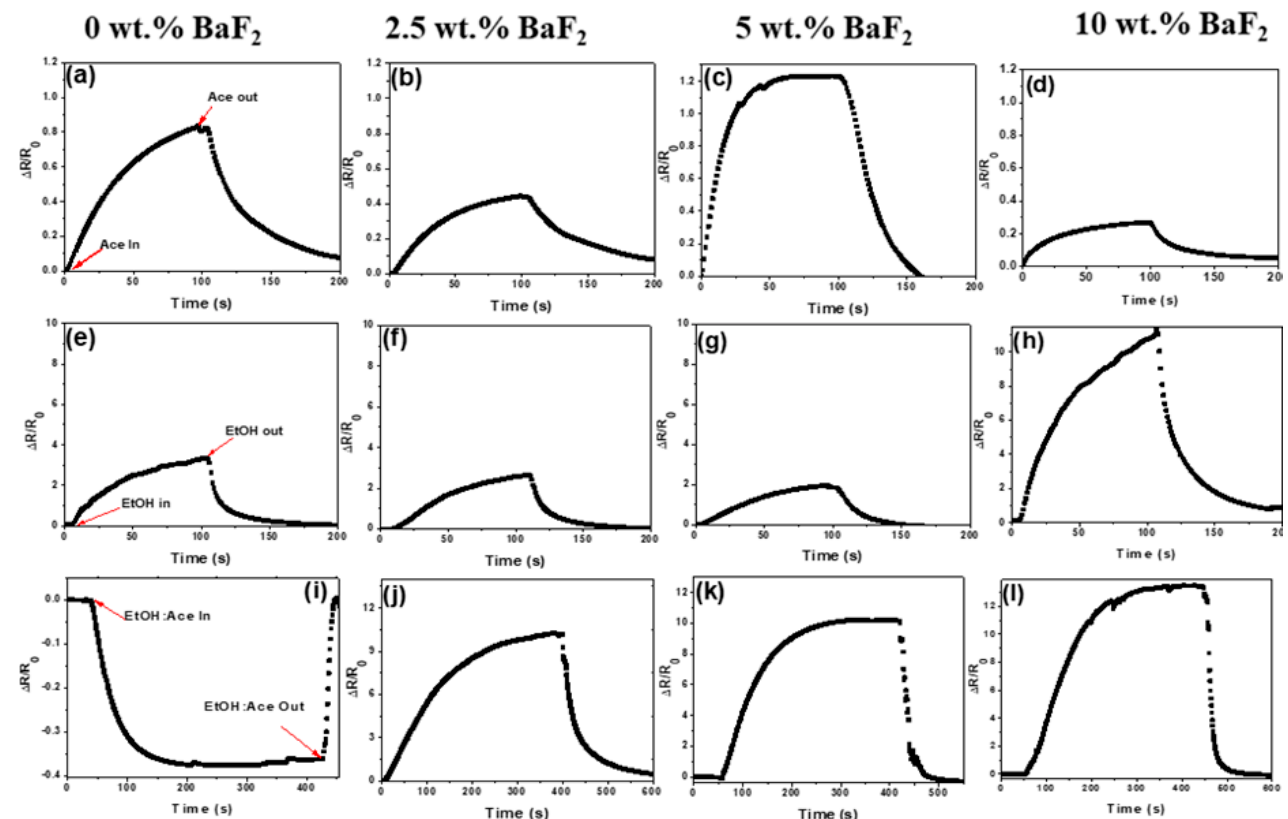
Figure 4: Responses and recovery times for devices fabricated after exposure and removal of 160 ppm of ( a – d ) acetone, ( e – f ) ethanol, and ( i – l ) acetone: ethanol vapours at optimum operating frequencies.